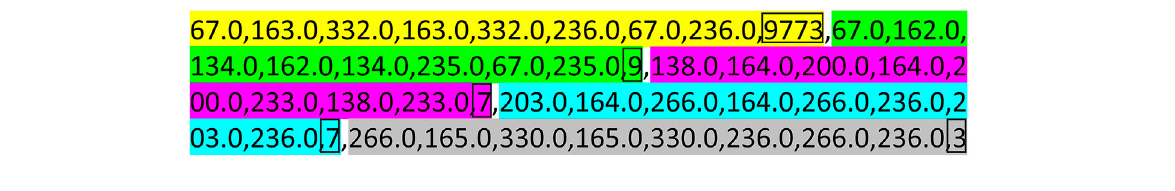
FIGURE5| Transcriptionformatofthelabeltext fi lespotElev_Num201.txt,whichcorrespondstotheimageshownin Figure4 .The fi rstset(yellow)representsthe outerboundingbox(xmin,ymin;xmax,ymin;xmax,ymax;xmin,ymax)andthefullelevationvalue(9773).Subsequentsets(green,pink,blue,gray)denotethebounding boxes and content of each character, in the same format.